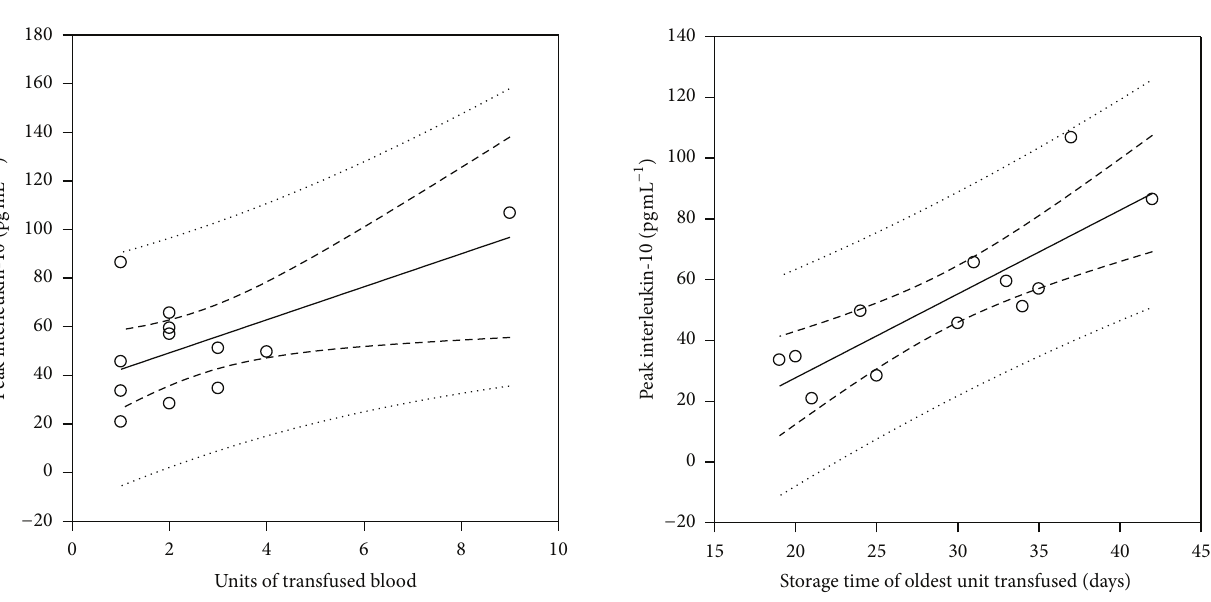
Figure 2: Scatter plot diagram of peak postoperative IL-10 values versus the number of units transfused, depicting a significant correlation ( 𝑟 2 = 0.38 , 𝑃 = 0.032 ).